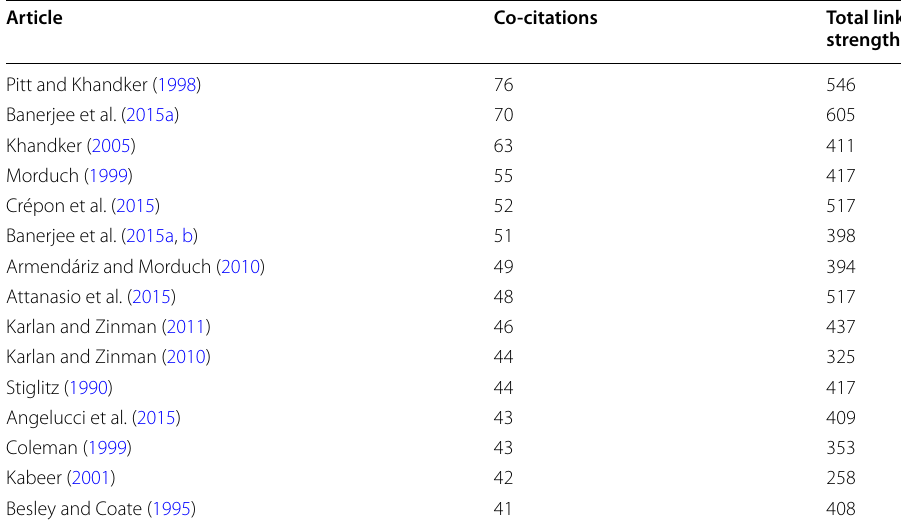
Table 7 Top 15 co-cited articles on sample statistic of 524 papers, published between 1:2012